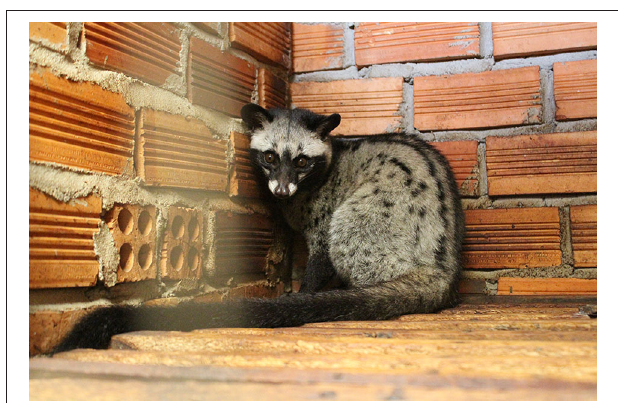
FIGURE 2 | Common palm civet photographed in its individual cage on a wildlife farm in Viet Nam in 2017. If caged individually it is possible to design viral surveillance efforts around the collection of fresh voided fecal samples from individual animals. Photo courtesy of the Wildlife Conservation Society, Viet